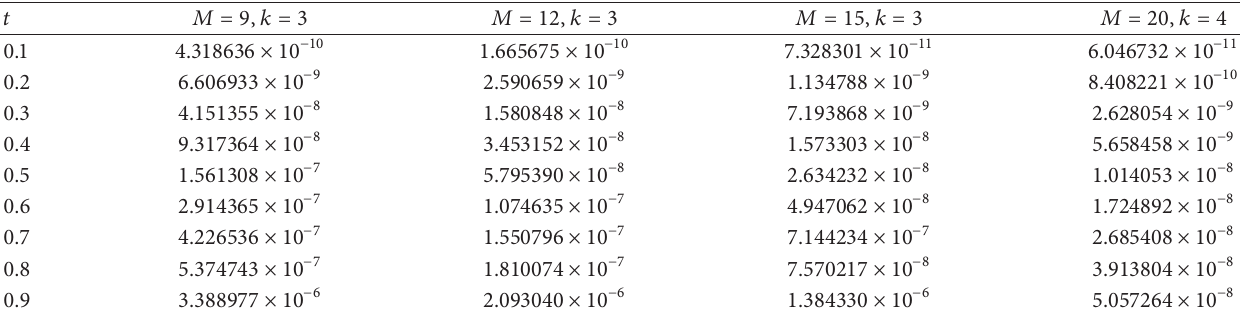
Table 3: Obtained absolute errors for different values of 𝑀 and 𝑘 for Example 3.